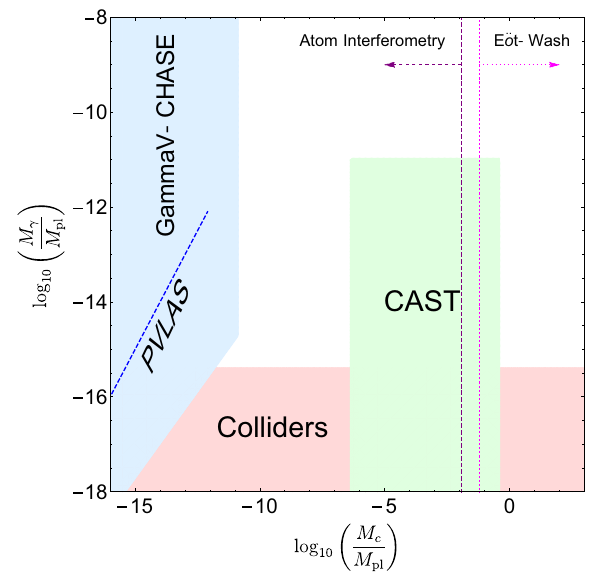
Fig. 9 Current constraints on the chameleon coupling to photons, M γ , for n = 1 models with Λ set to the dark energy scale. The bounds coming from each specific test are indicated in the